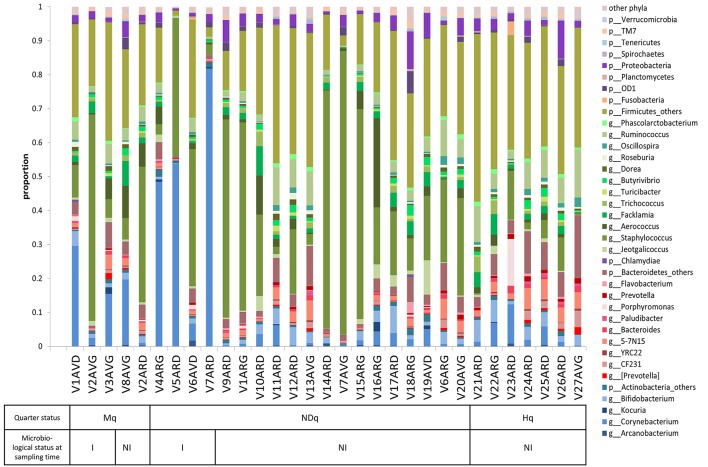
Bovine teat taxonomic profiles combining taxonomic levels L2 (phyla) and L6 (genera). Each bar represents a sample. Genera present in at least 5‰ abundance in a given sample are displayed, whereas genera present in less than 5‰ are pooled in the corresponding phylum and referred to as “phylum_others.” Actinobacteria are displayed in blue, Bacteroidetes in red, Firmicutes in green and Proteobacteria in purple. Samples were characterized with regard to: (i) quarter health status (Mq, has already developed mastitis; Hq, healthy; NDq, not determined status); and (ii) microbiological status at sampling time (I, infected; NI, not infected), as a result of plate counts on Columbia II containing 5% sheep blood.